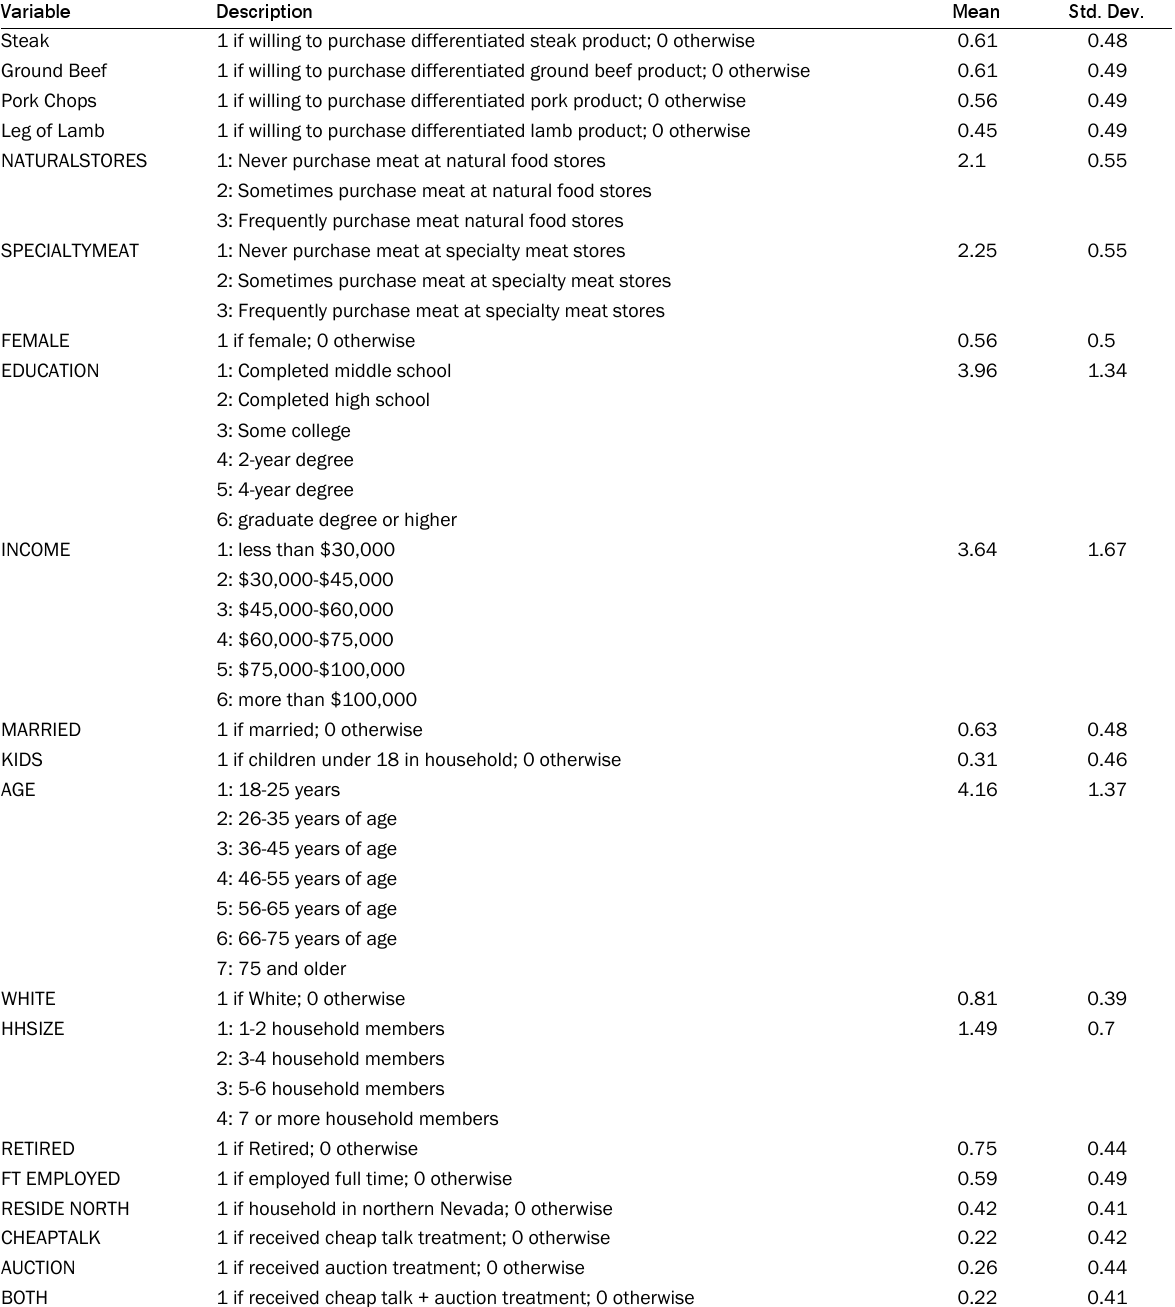
Table 2. Model Variable Descriptions and